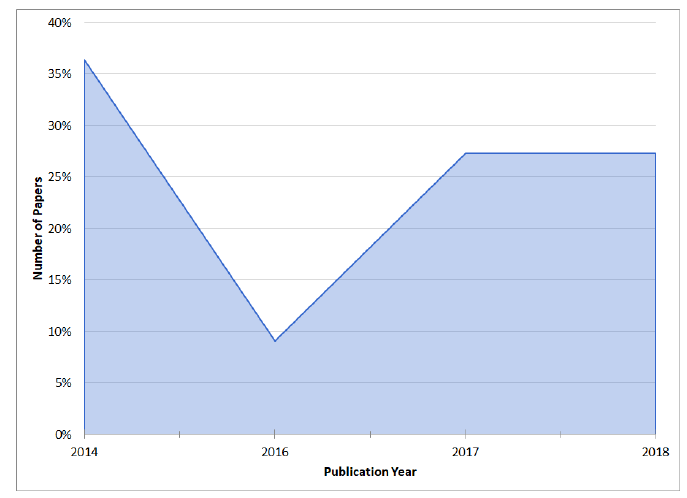
Figure 7. Camera usage.